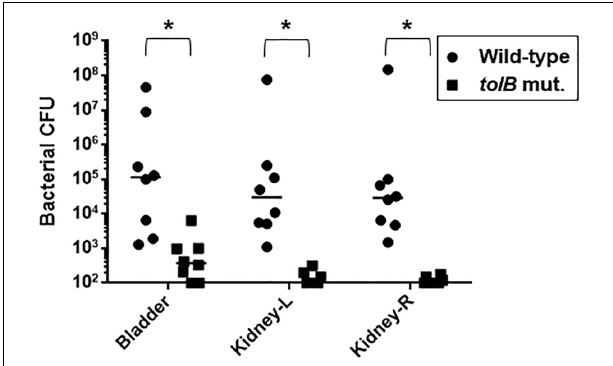
FIGURE 4 | Colonization of the wild-type and tolB mutant in bladder and kidneys of UTI mice. At 48 h of post infection, bladder, left kidney (kidney-L) and right kidney (kidney-R) were aseptically and separately removed. Each cell number of bacteria isolated from these organs was represented by CFU (colony forming unit). Each data point represents a sample from an individual mouse. Horizontal bars indicate the median values. The tolB mutant was colonized in both bladder and kidneys in significantly lower degree than the wild-type parent ( P < 0.01). Asterisks denote significance for values.